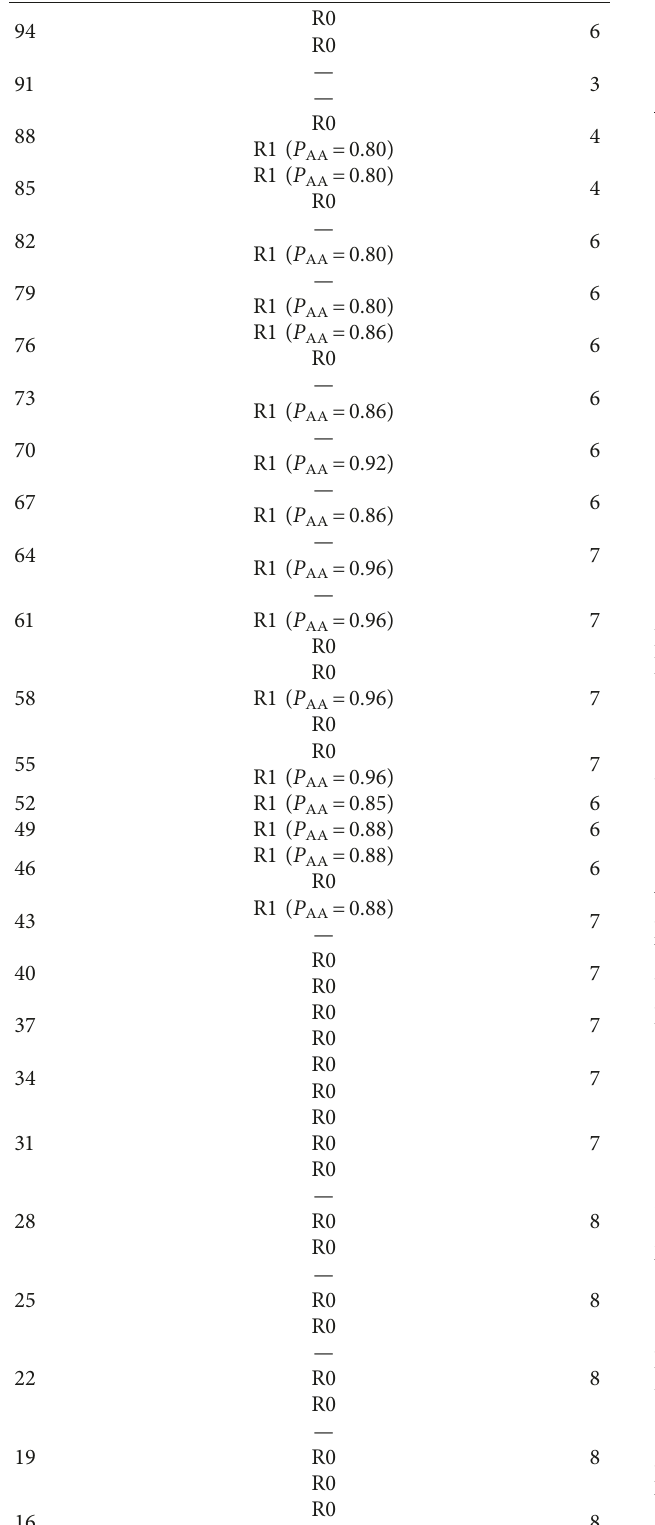
Table 2: Some structural parameters obtained from the quanti- tative XRD analysis in the case of the unstressed sample along the desorption